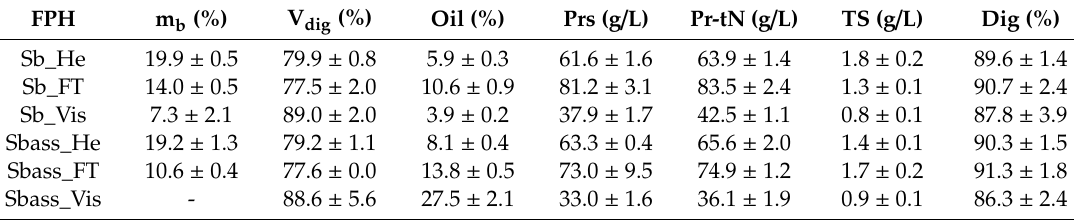
Table 3. Mass balances and proximal analysis of the products recovered from Alcalase hydrolysates of seabream and seabass by-products. Shown errors are the confidence intervals for n = 3 (replicates of di ff erent hydrolysates) and α = 0.05. m b : percentage of the bones recovered ( w / w of crude substrate); V dig : yield of digestion process; Oil: total oil recovered ( v / w of crude substrate); Prs: Total